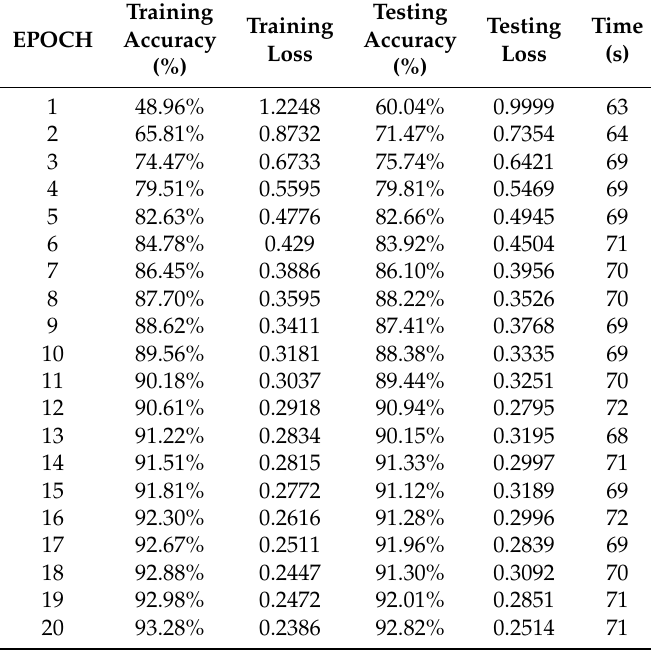
Table 2. A summary of the experimental work in the training and testing stages using ANN with different number of epochs versus time-efficiency.